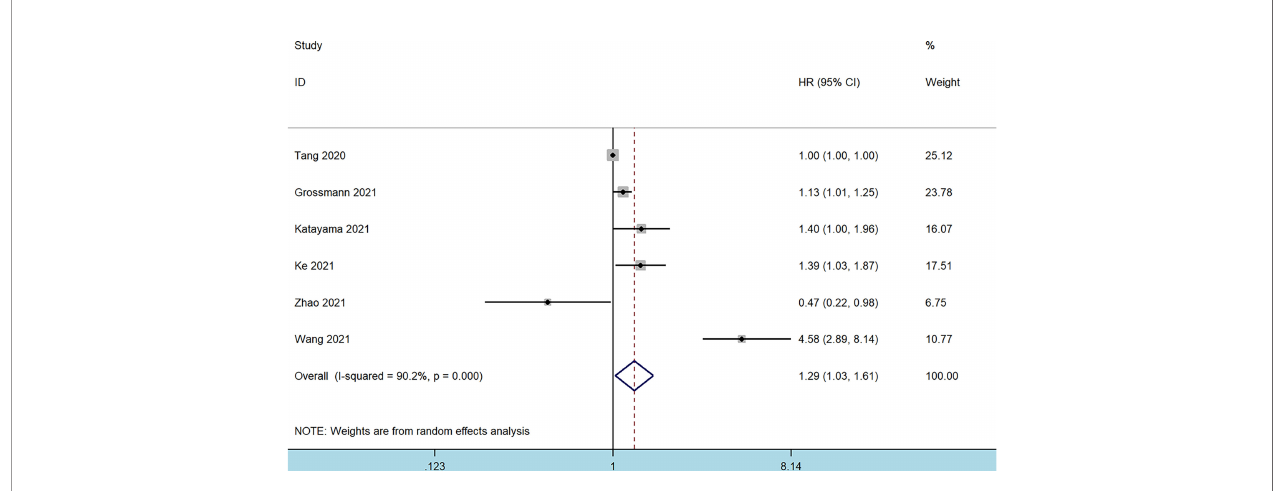
FIGURE 4 | Forest plot of the association between systemic immune-in fl ammation index and recurrence-free survival in patients with bladder